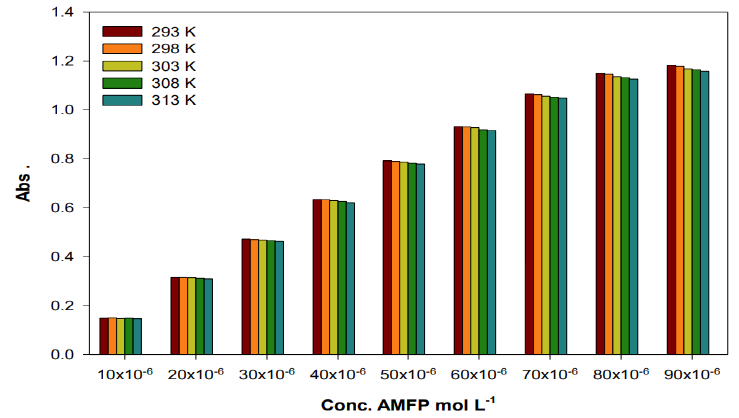
Figure 8. Effect of temperature on the absorbance of the AMFP – TCNE CT complex in DCE.